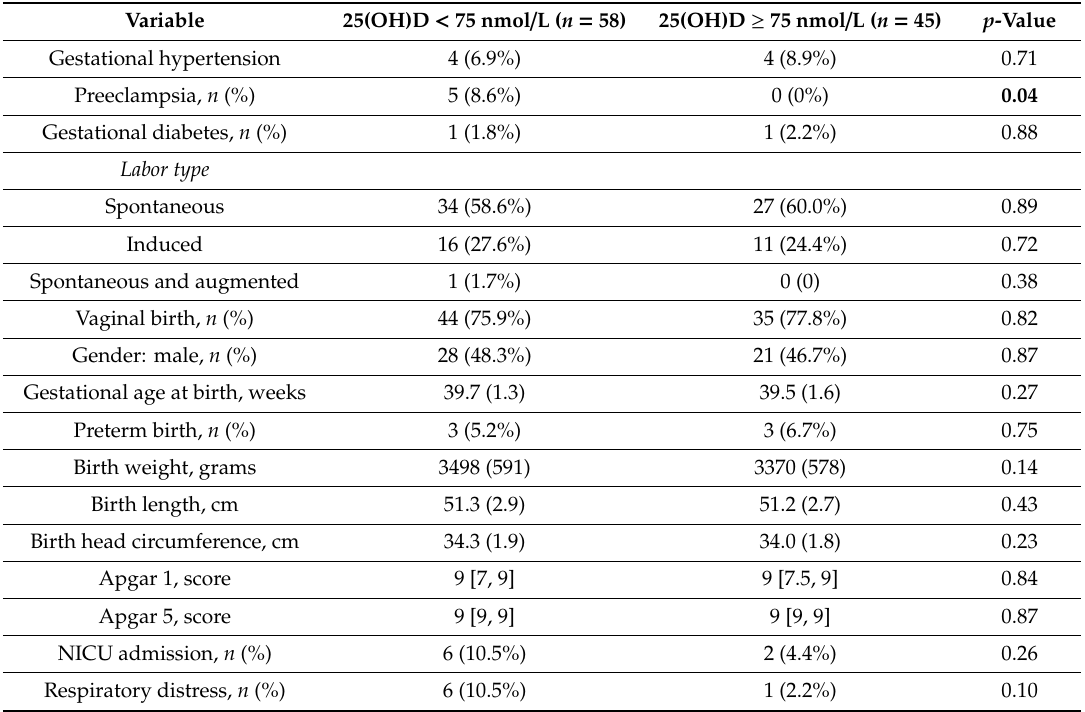
Table 3. Maternal and neonatal outcomes by maternal vitamin D status during pregnancy for women with